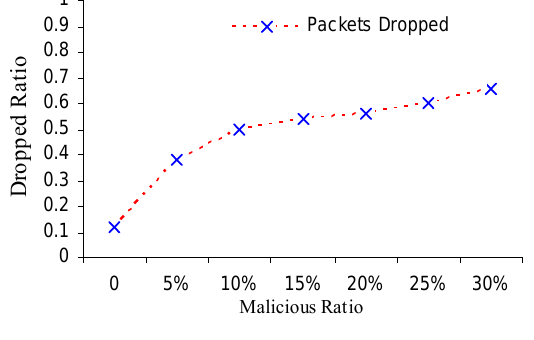
Figure 7 . Selective forwarding attack run with seven scenarios implemented according to the number of malicious nodes on the network, the energy consumption of each sensor node [17] is as follows: Ea=100 pJ/bit/m2, Ee = 50 nJ/bit and Ec = 5 nJ/bit were consumed for transmitting, receiving and listening respectively each sensor needs to send a packet of length R = 400 bits to the cluster head on random time. Cluster head period T is set as 2,000s, and the execution time of task is set as = 0.005 s. The data packet size is 2 KB and the sensing range to 64 meters.